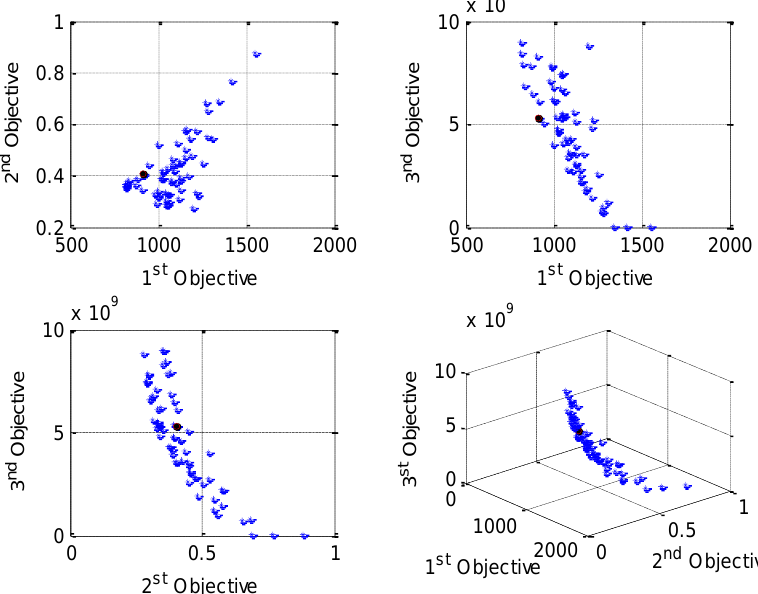
Figure 16. Pareto solution set, MSSA algorithm (second scenario).